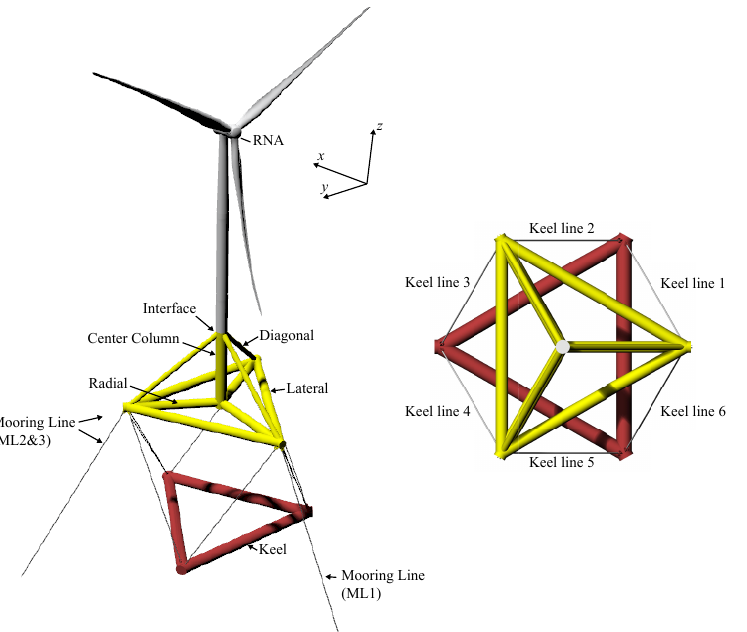
Figure 1. Illustration of the TetraSpar FOWT foundation with definition of components and coordi- nate system. Left : perspective view. Right : top